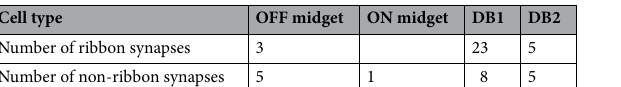
Cell type OFF midget ON midget DB1 DB2 Number of ribbon